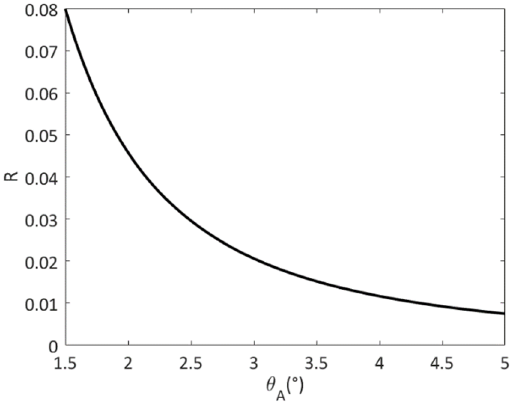
Figure 1. The relationship between the sun filled-beam efficiency and beamwidth.